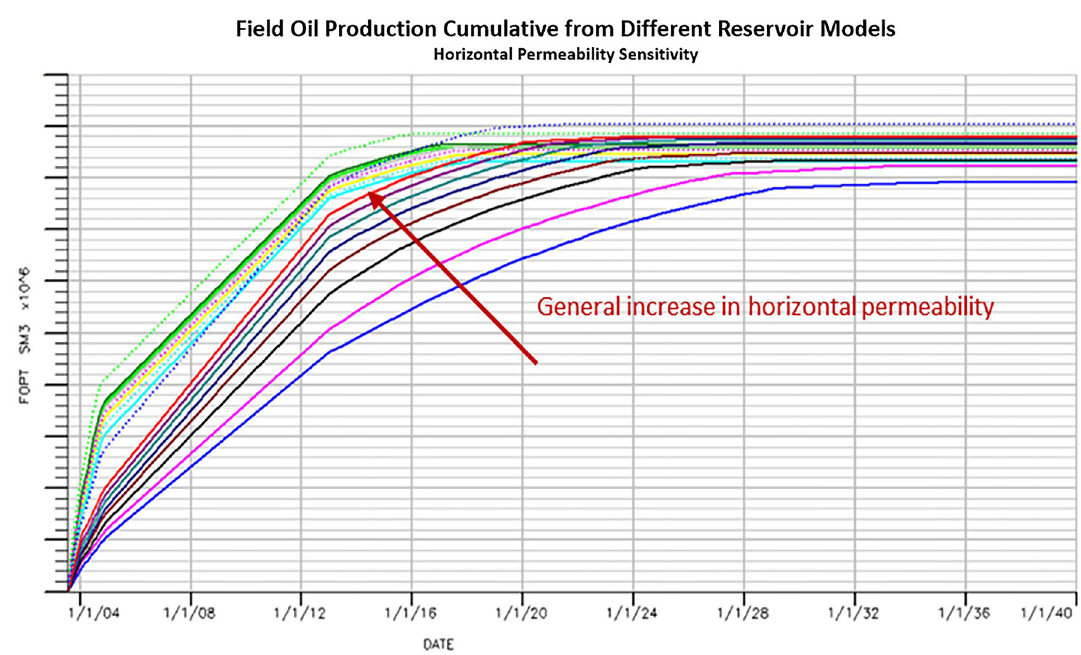
Fig. 3 Impact of reservoir horizontal permeability on WAG recovery factor